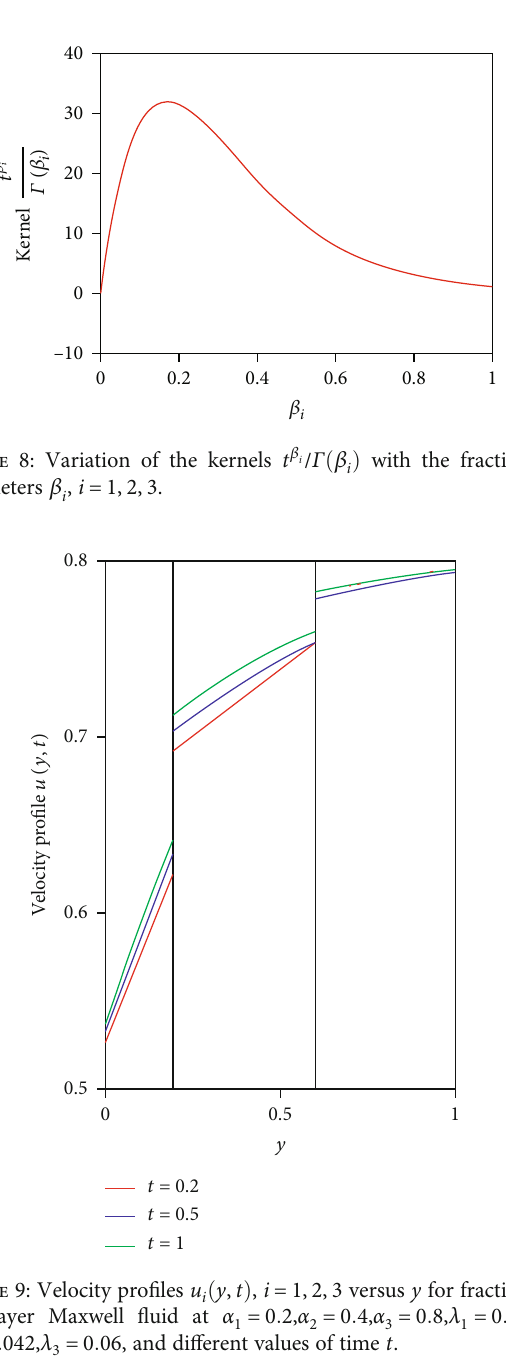
ð y , t Þ , i = 1, 2, 3 versus y for fractional i = 0 : 2, α = 0 : 4, α = 0 : 8, λ = 0 : 021, 1 2 3 1